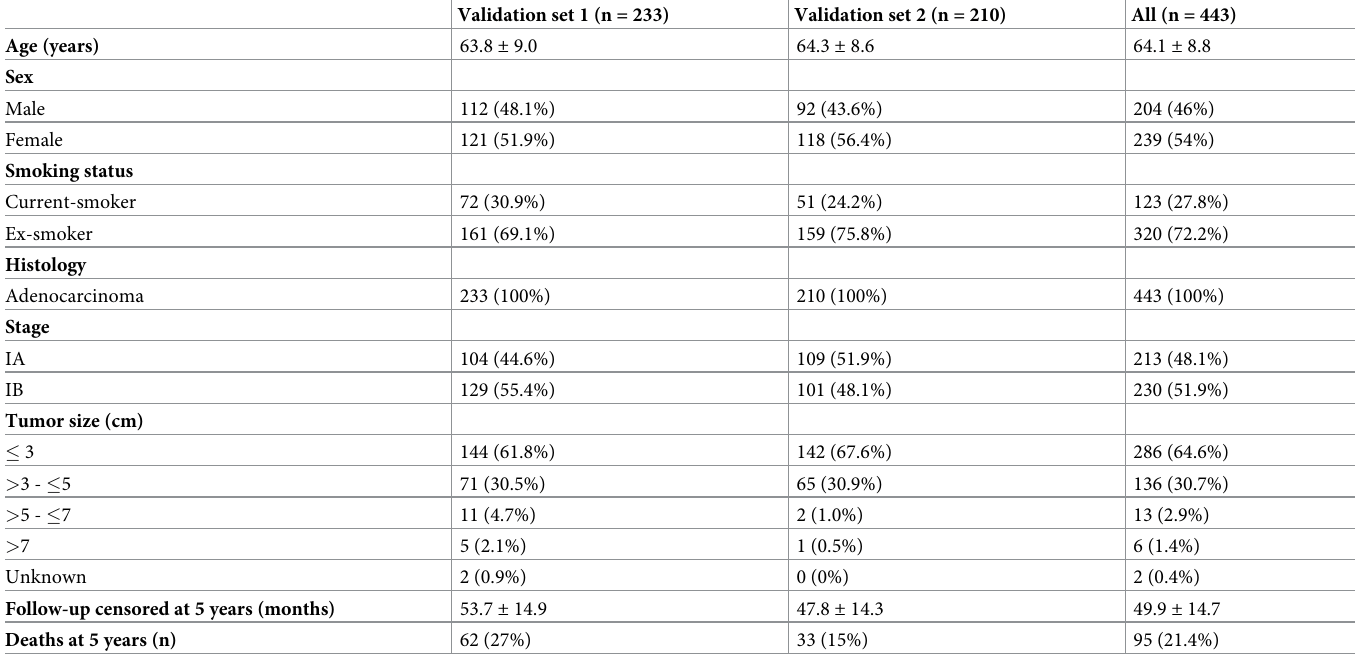
Table 1. Clinical characteristics of the patients that underwent curative intent resection for stage I